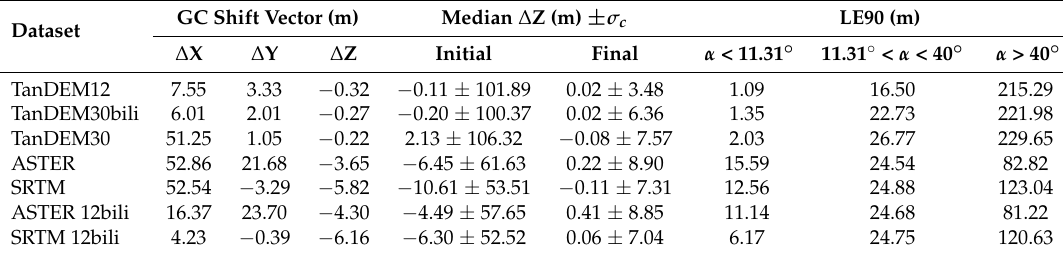
Table 2. Results of corrections of DEMs relative to ALS DEM. Median ∆ Z calculated for